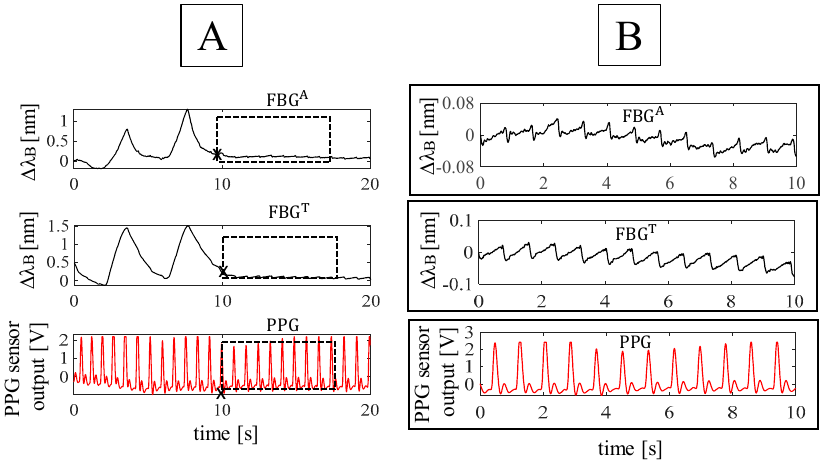
Figure 6. ( A ) Starting points selected on the synchronized signals and ( B ) zoom of the 10 s-window of apnea considering the outputs of FBG A , FBG T , and PPG.